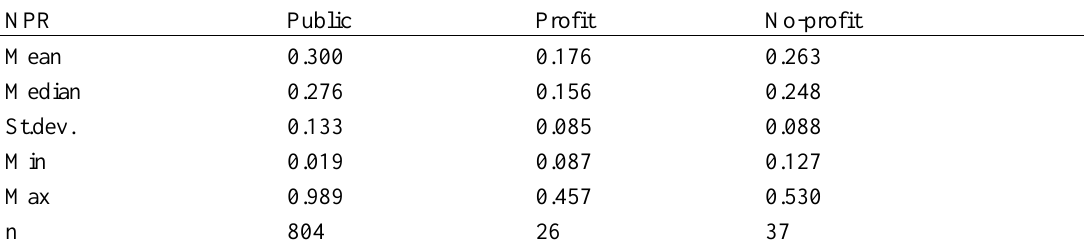
Descriptive statistics of quality of care, by provider category NPR Public